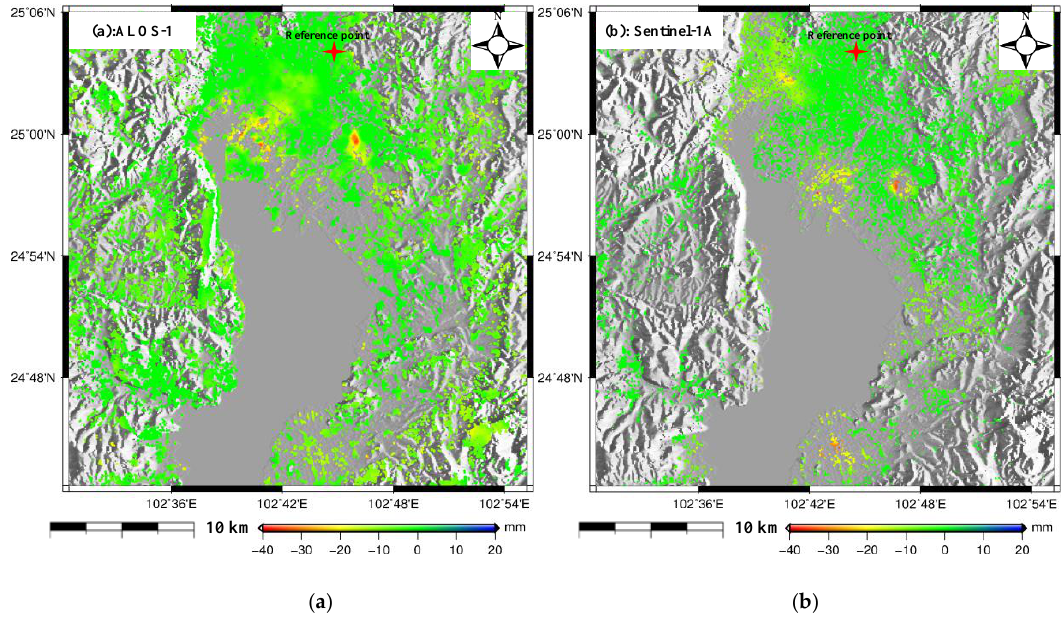
Figure 8. Comparison of deformation between the ALOS-1 and Sentinel-1A datasets. ( a ) The result of ALOS-1. ( b ) The result of Sentinel-1A .